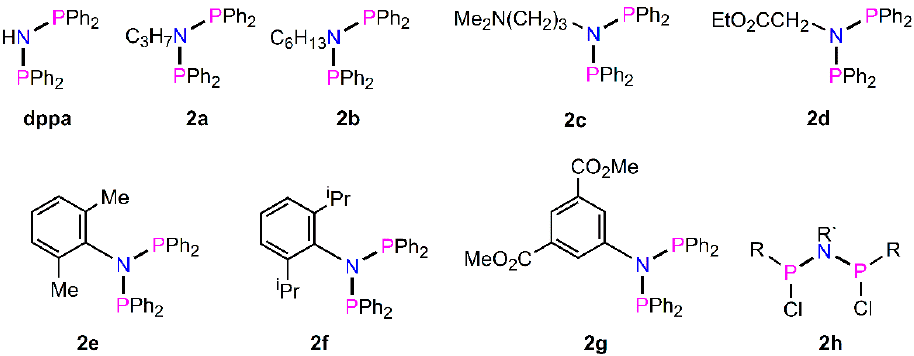
Figure 3. Selected examples of known bis(phosphino)amines.